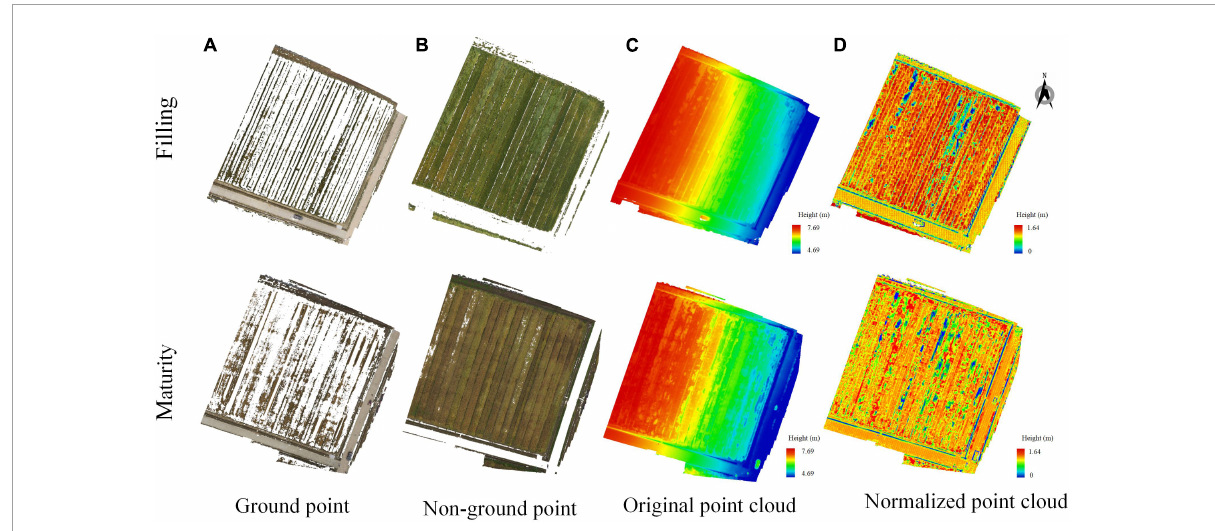
FIGURE4 Normalized point cloud of wheat field in different periods. (A) ground point, (B) non-ground point, (C) original point cloud, and (D) normalized point